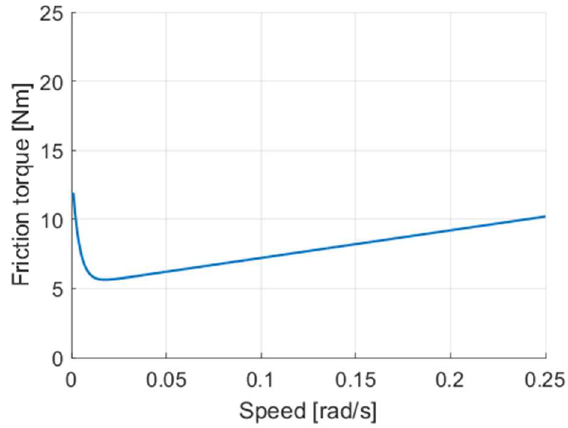
Figure 6. Friction torque.